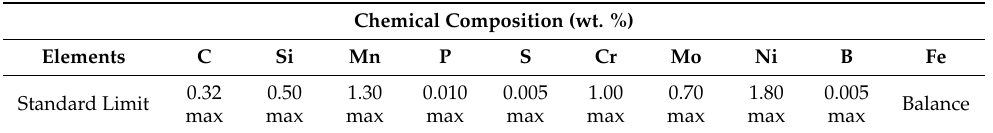
Table 2. The chemical composition of standard material (Armox 500T) (SSAB, Stockholm, Sweden) used for potential armoring applications.